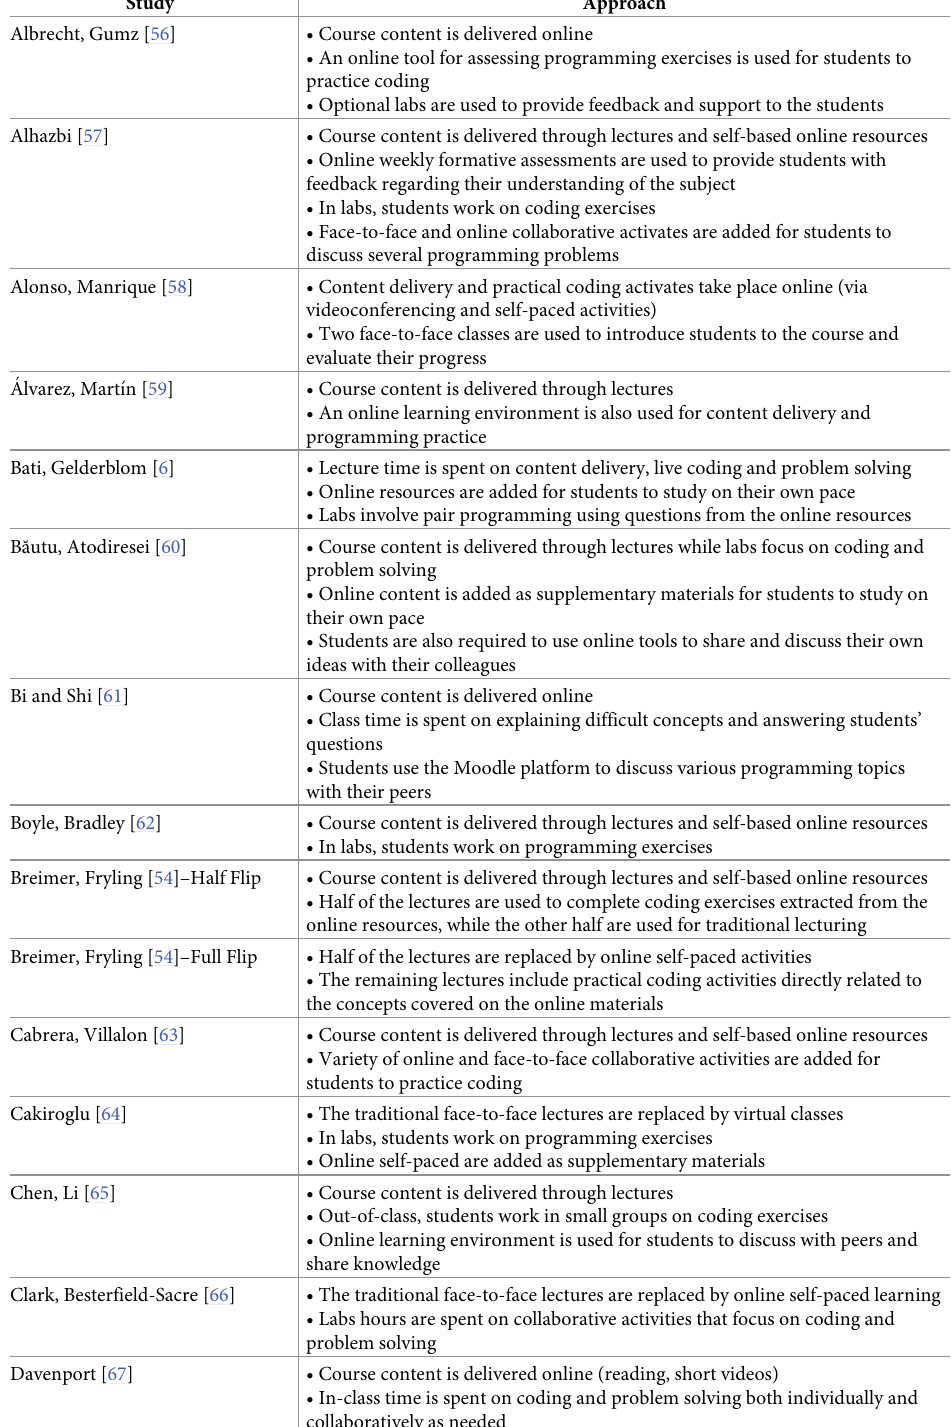
Table 5. Approaches applied by the reviewed